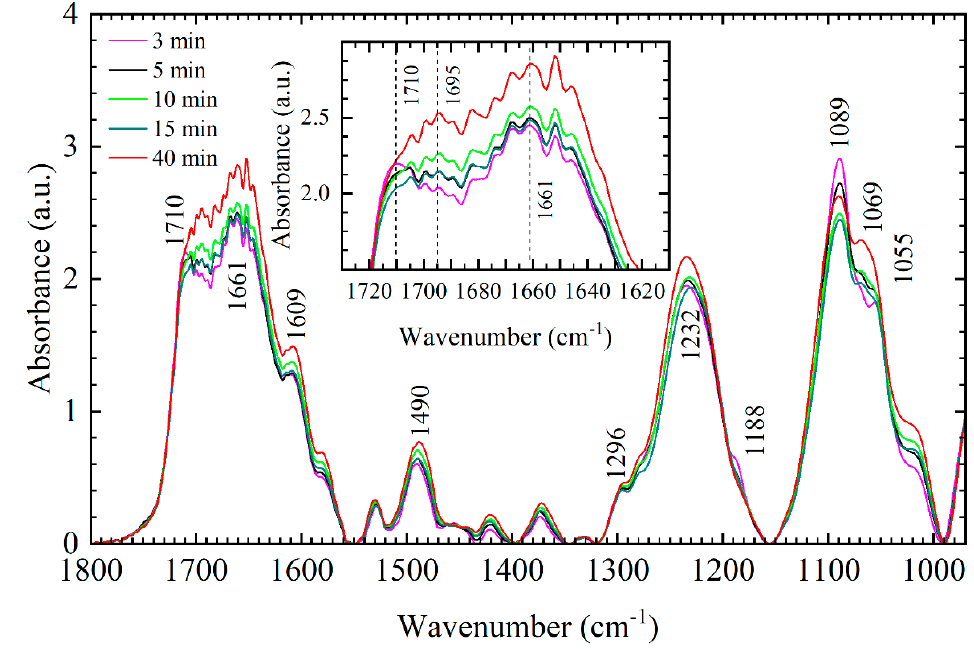
Figure 1. The average FTIR spectra of DNA thin films of different hydration levels in the 1800–970 cm − 1 range: 3 min film (purple), 5 min film (black), 10 min film (light green), 15 min film (dark green), 40 min film (red). Inset: enlarged view of the respective DNA thin film in the base region (1730–1610 cm − 1 ). Numbers denote identified bands of 10 min film.